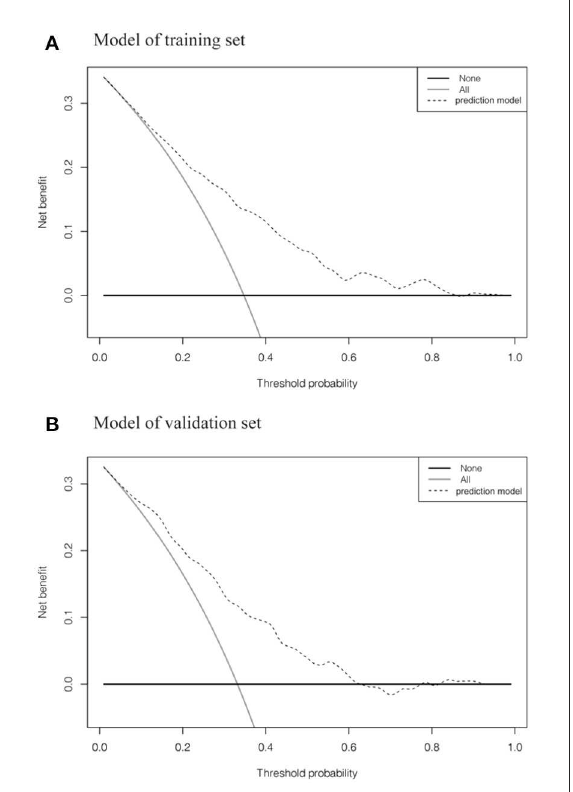
FIGURE5 Decision curve analysis of suicidal ideation in the training set and validation set. (A, B) showed the decision curves of the training set and validation set, respectively. The y axis measures the net benefit. The dotted line represents the suicidal ideation incidence risk nomogram for MSM. The gray solid line represents the assumption that all patients are diagnosed as having suicidal ideation. The black solid line represents the assumption that no participants are identified as having suicidal